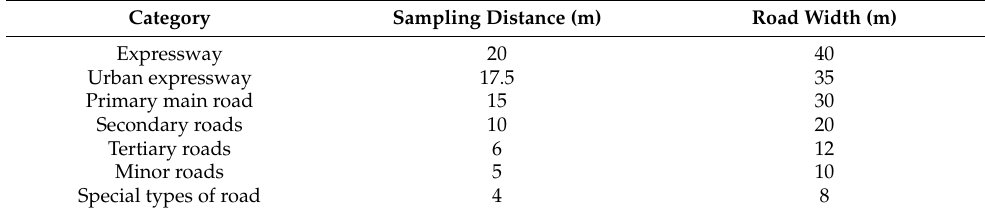
Table 3. Sampling distances of different levels of roads.